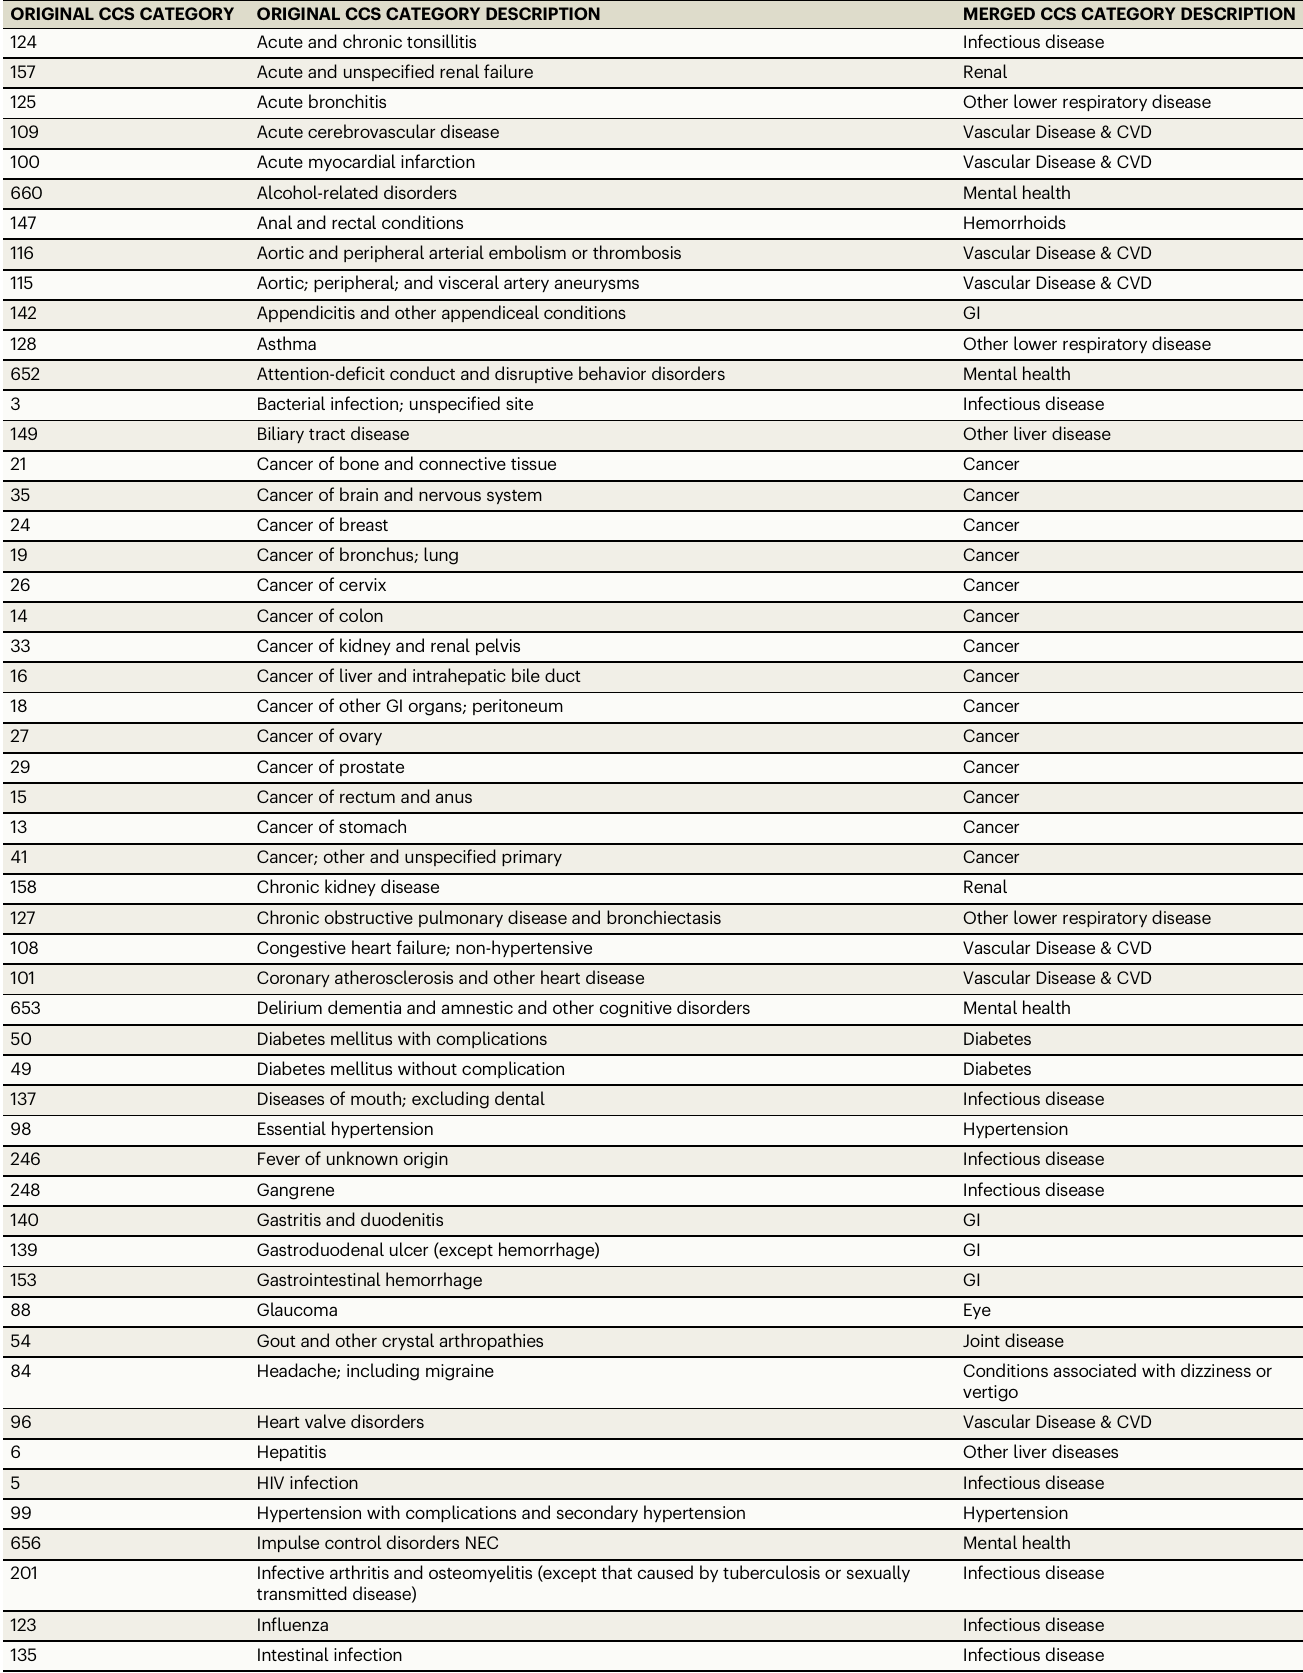
Table 7 | CCS categories merged in analysis ORIGINAL CCS CATEGORY ORIGINAL CCS CATEGORY